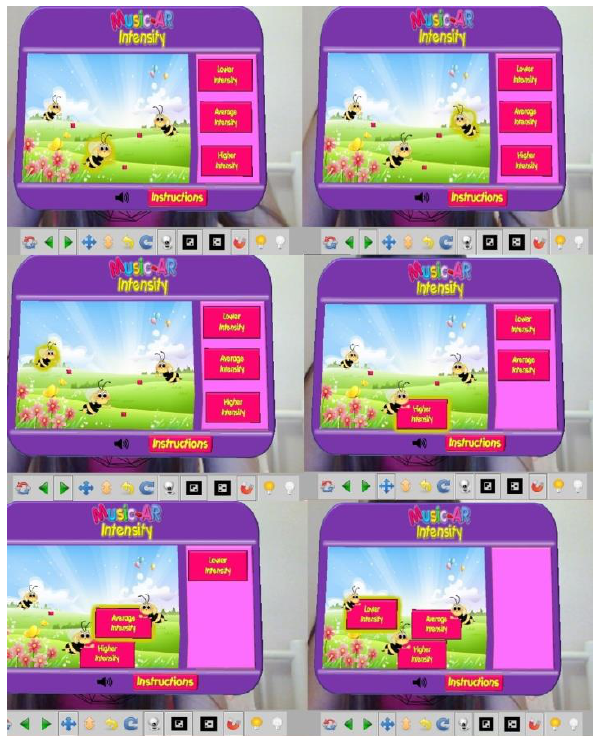
Figure 5. Main screens running the game on the